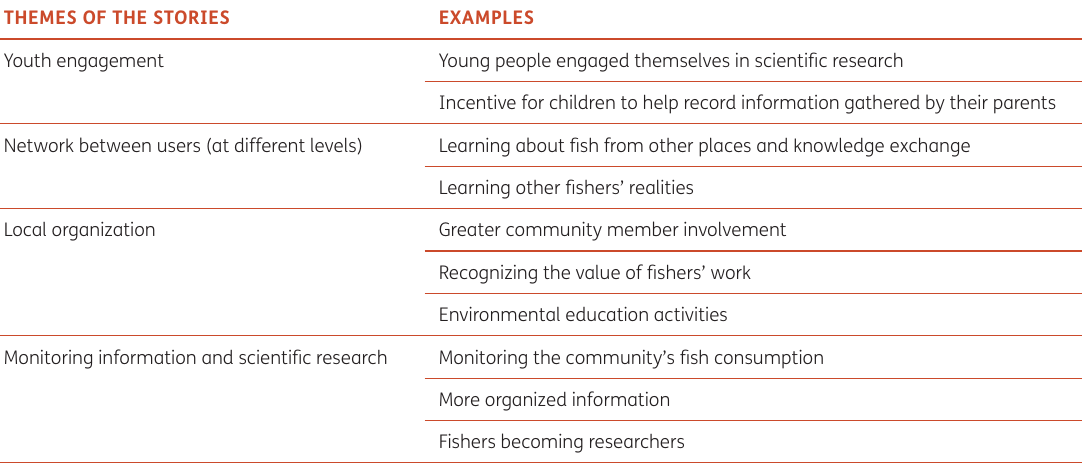
Table 3 Outcomes of the Most Significant Change exercise elaborated during the citizen science